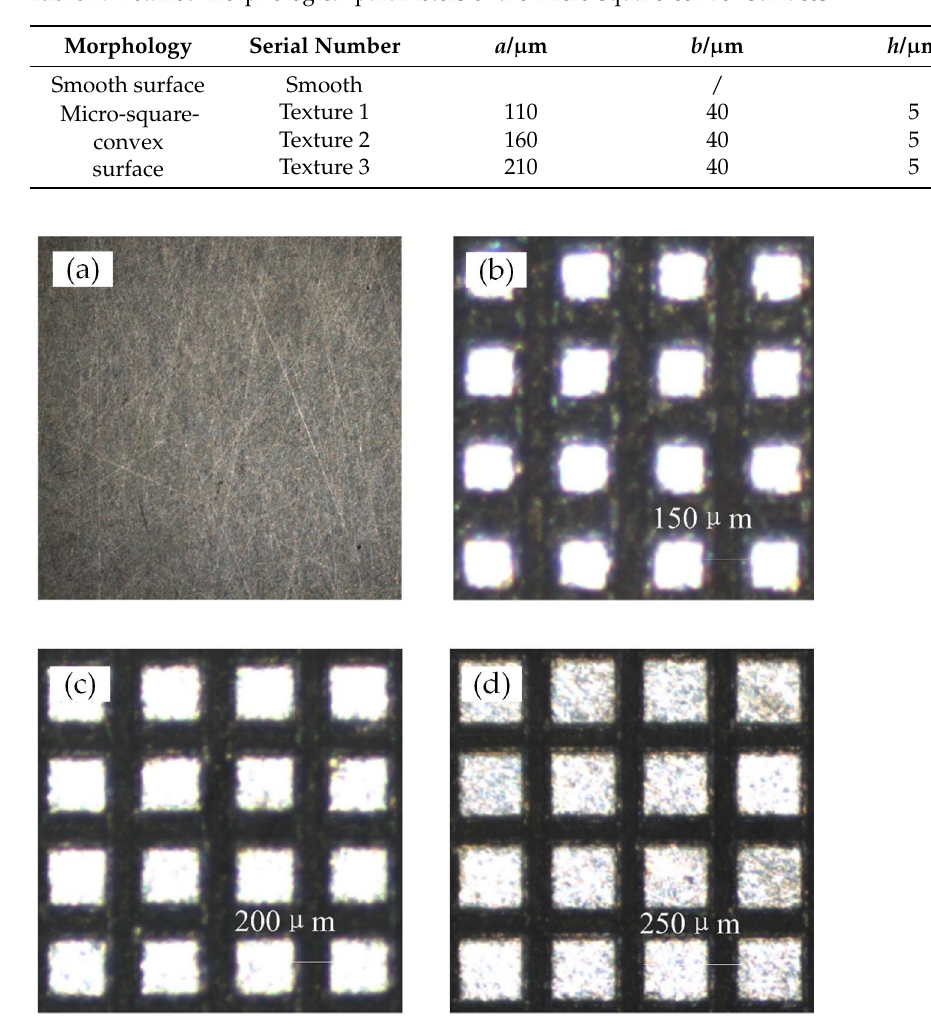
Figure 3. Static contact angle of different surfaces: ( a ) smooth surface; ( b ) Textured surface 1; ( c ) Textured surface 2; and ( d ) Textured surface 3. In order to analyze the EDL influence on wettability, contact angles of the above sur- faces were calculated by the present model described in Section 2.2. The values of the contact angles are listed in Table 2. Here, the liquid-gas interface tension is γ lv = 71.42 ×